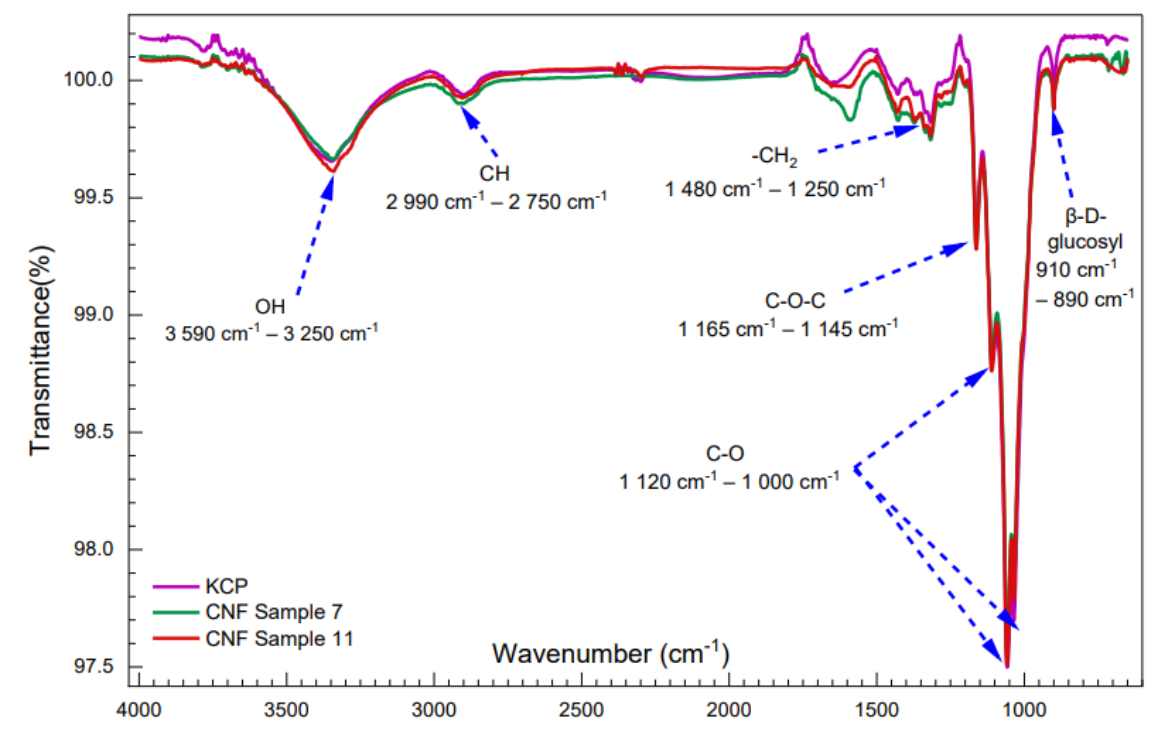
Figure 5. FTIR spectral of the KCP sample (purple curve), CNF sample No. 7 (green curve), and CNF sample No. 11 (red curve).